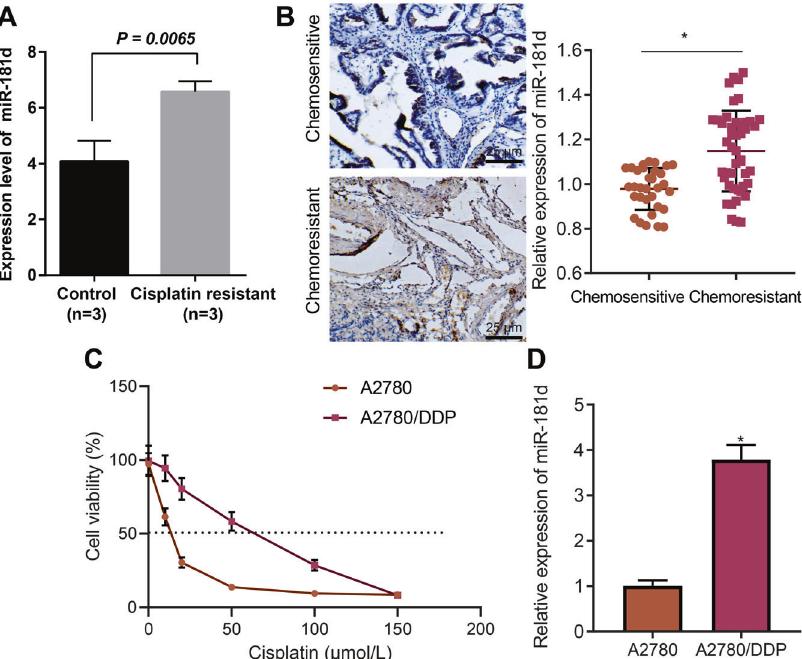
Fig. 1 miR-181d is highly expressed in DDP-resistant OC tissues or cells. A Expression of miR-181d in DDP-resistant and DDP-sensitive OC cells in the GSE148251 dataset. B In-situ hybridization assay of the miR-181d expression in clinical tissue samples of chemo-resistant ( n = 46) and chemo-sensitive ( n = 32) OC patients. C CCK-8 assay evaluation of viability of A2780 and A2780/DDP cells after treatment with DDP at different concentrations (0, 10, 20, 50, 100, and 150 μ mol/L) for 48 h. IC50 of A2780 = 12.72 μ mol/L, and IC50 of A2780 DDP = 55.03 μ mol/L. D RT-qPCR detection of miR-181d expression in A2780/DDP and A2780 cells, normalized to U6. Cell experiments were repeated three times independently. * p < 0.05 versus A2780 cells or chemo-sensitive OC